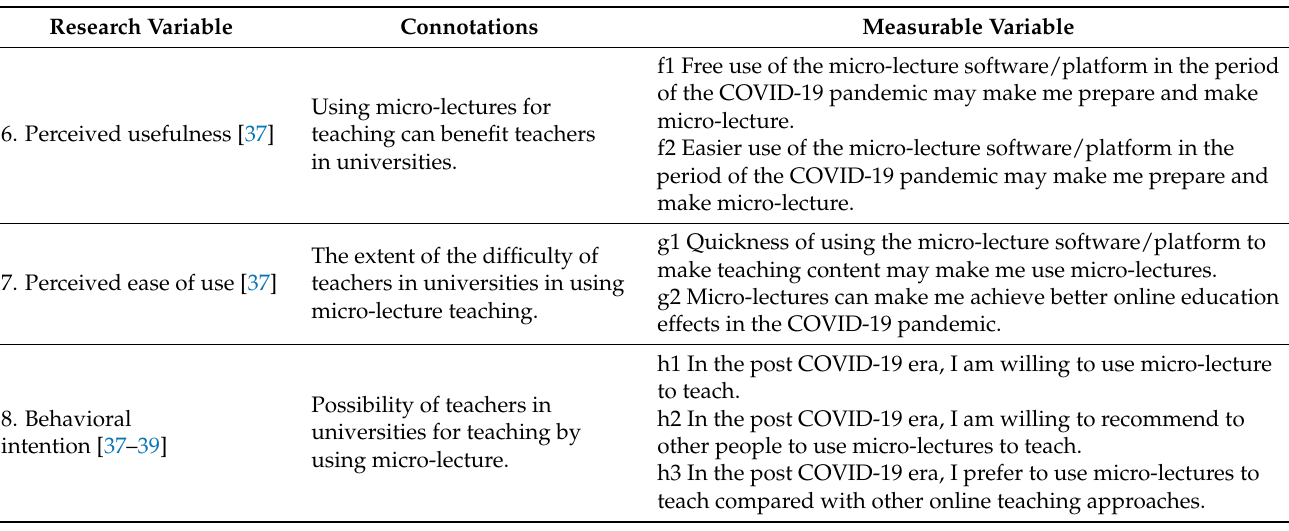
Table 8. Connotations and measurable variables of perceptibility and behavioral